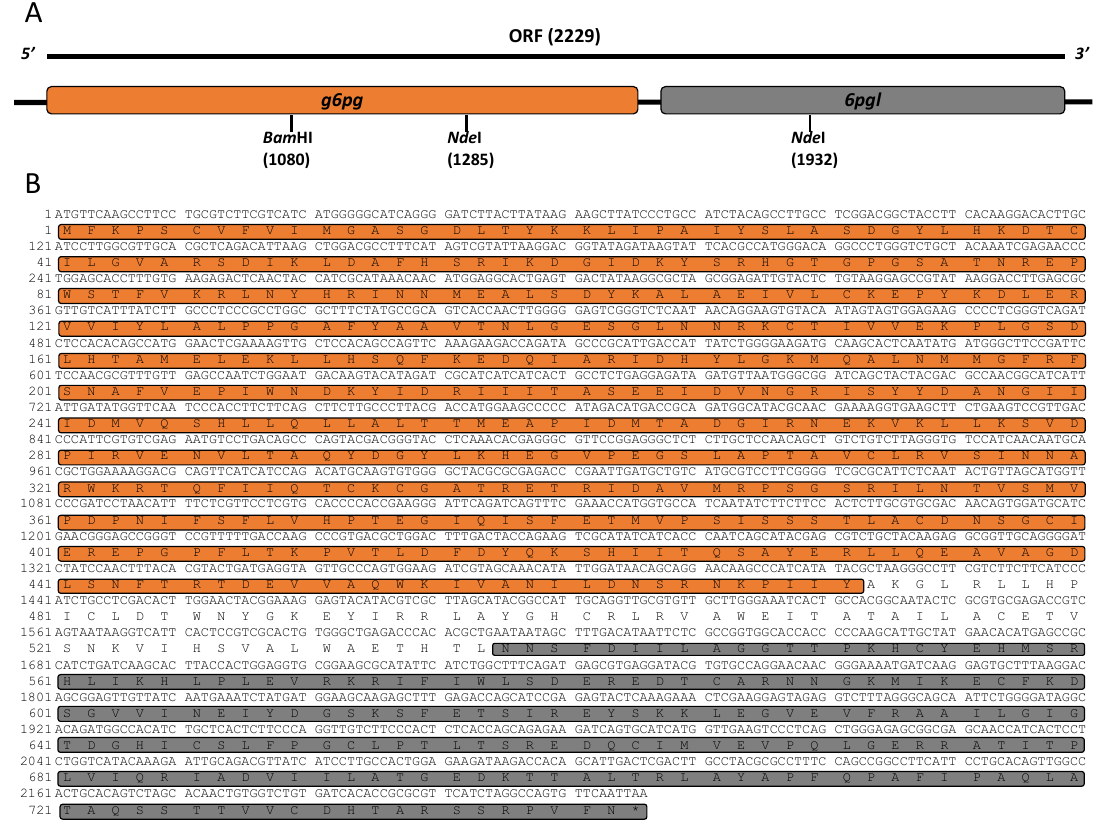
Figure 2. Structure and the sequence of the g6pd :: 6pgl gene from G . lamblia . ( A ) Full-length and open reading frame (ORF) genomic DNA structures of g6pd :: 6pgl , encoding G6PD::6PGL. ( B ) Nucleotides and deduced amino acid sequence of the g6pd :: 6gpl gene. Two conserved domains are observed, one for G6PD (CDD: 235579) indicated in orange, and another for 6PGL (CDD: 294243) indicated in gray.